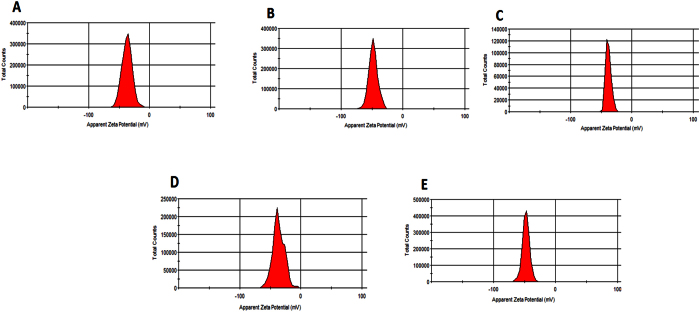
Zeta potential curves of the gradient alloyed L-cysteine (A) Cd2.2Zn1.0TeS, (B) Cd2.0Zn1.0TeS, (C) Cd1.8Zn1.0TeS, (D) Cd1.6Zn1.0TeS and (E) Cd1.4.Zn1.0TeS QDs.